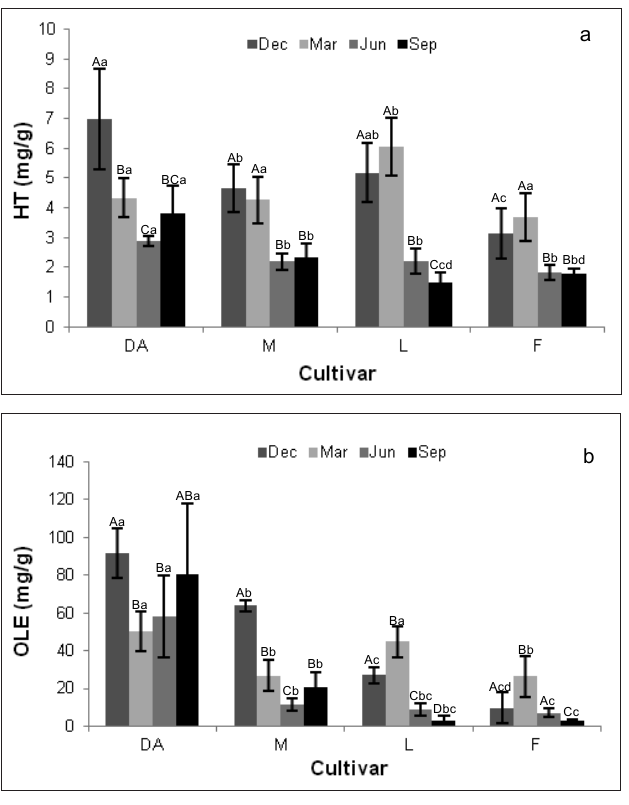
Fig. 6: Hydroxytyrosol (a) and oleuropein (b) contents (mg/g, mean values) in olive leaves harvested in different periods from different culti- vars. Error bars indicate SD of the means (n = 5). Means with differ - ent capital letters indicate significant differences ( P ≤ 0.05) among months within the same olive cultivar. Means with different lower case letters indicate significant differences ( P ≤ 0.05) among olive cultivars within the same month. Abbreviations of olive cultivars and harvesting periods have been reported in Fig. 4.